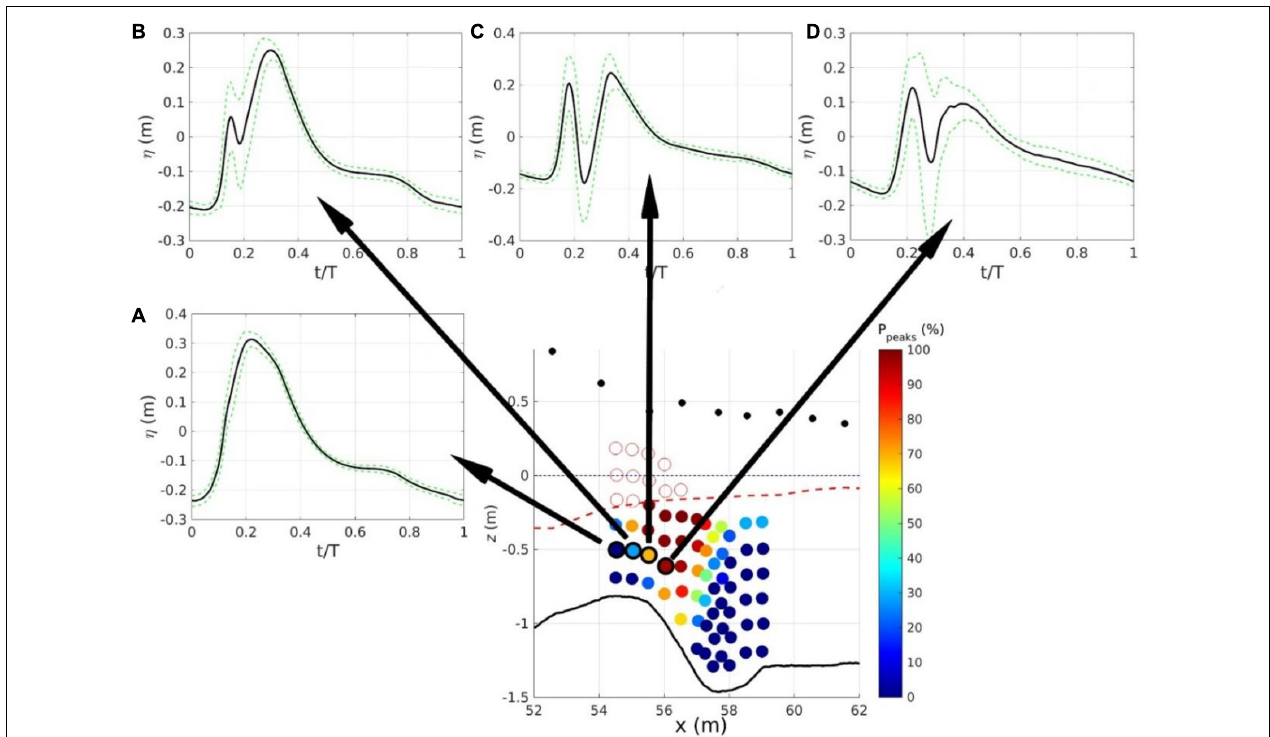
FIGURE 6 | Presence of air bubble peaks induced by wave breaking (P peaks variable), in percentage and as a function of the bar-trough geometry (lower central panel). Plots (A–D) depict the ensemble free water surface (black continuous line) computed from a PPT signal, progressively more affected by the bubble cloud as the wave breaks over the bar and evolves into the following seabed trough. The ensemble variation of registered free surface signals within the incoming wave train is represented by the green dashed lines, corresponding to one standard deviation above and below the ensemble average and showing how the variability and uncertainty increase with breaking and air bubble non-linear interactions, as the regular incoming waves progress from bar crest to trough.